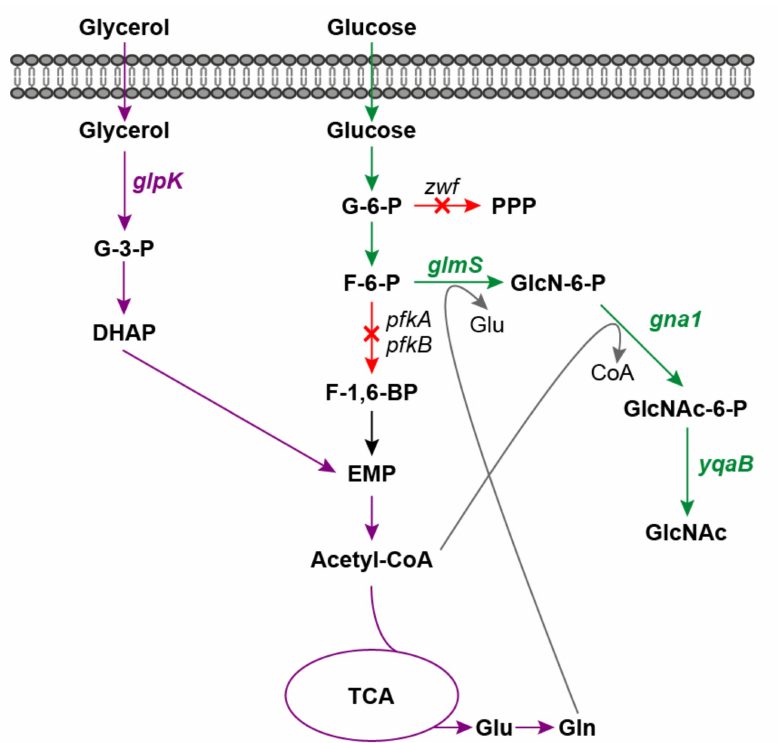
Figure 1. Schematic diagram of GlcNAc production via synergistic carbon co-utilization mechanism. Red arrows and crosses indicate gene deletions; green arrows indicate the GlcNAc biosynthesis path- way from glucose; purple arrows indicate glycerol utilization pathway. G-3-P, glycerol-3-phosphate; DHAP, glycerone phosphate; G-6-P, glucose-6-phosphate; F-6-P, fructose-6-phosphate; F-1,6-BP, fructose-1,6-bisphosphate; EMP, Embden-Meyerhof-Parnas pathway; TCA, tricarboxylic acid cycle; Glu, glutamic acid; Gln, glutamine; PPP, pentose phosphate pathway; GlcN-6-P, glucosamine-6- phosphate; GlcNAc, N-acetylglucosamine; glpK , glycerol kinase gene; zwf , glucose-6-phosphate dehydrogenase gene; glmS , glucosamine-6-phosphate synthase gene; gna1 , glucosamine-6-phosphate N-acetyltransferase gene; yqaB , GlcNAc-6-phosphate phosphatase